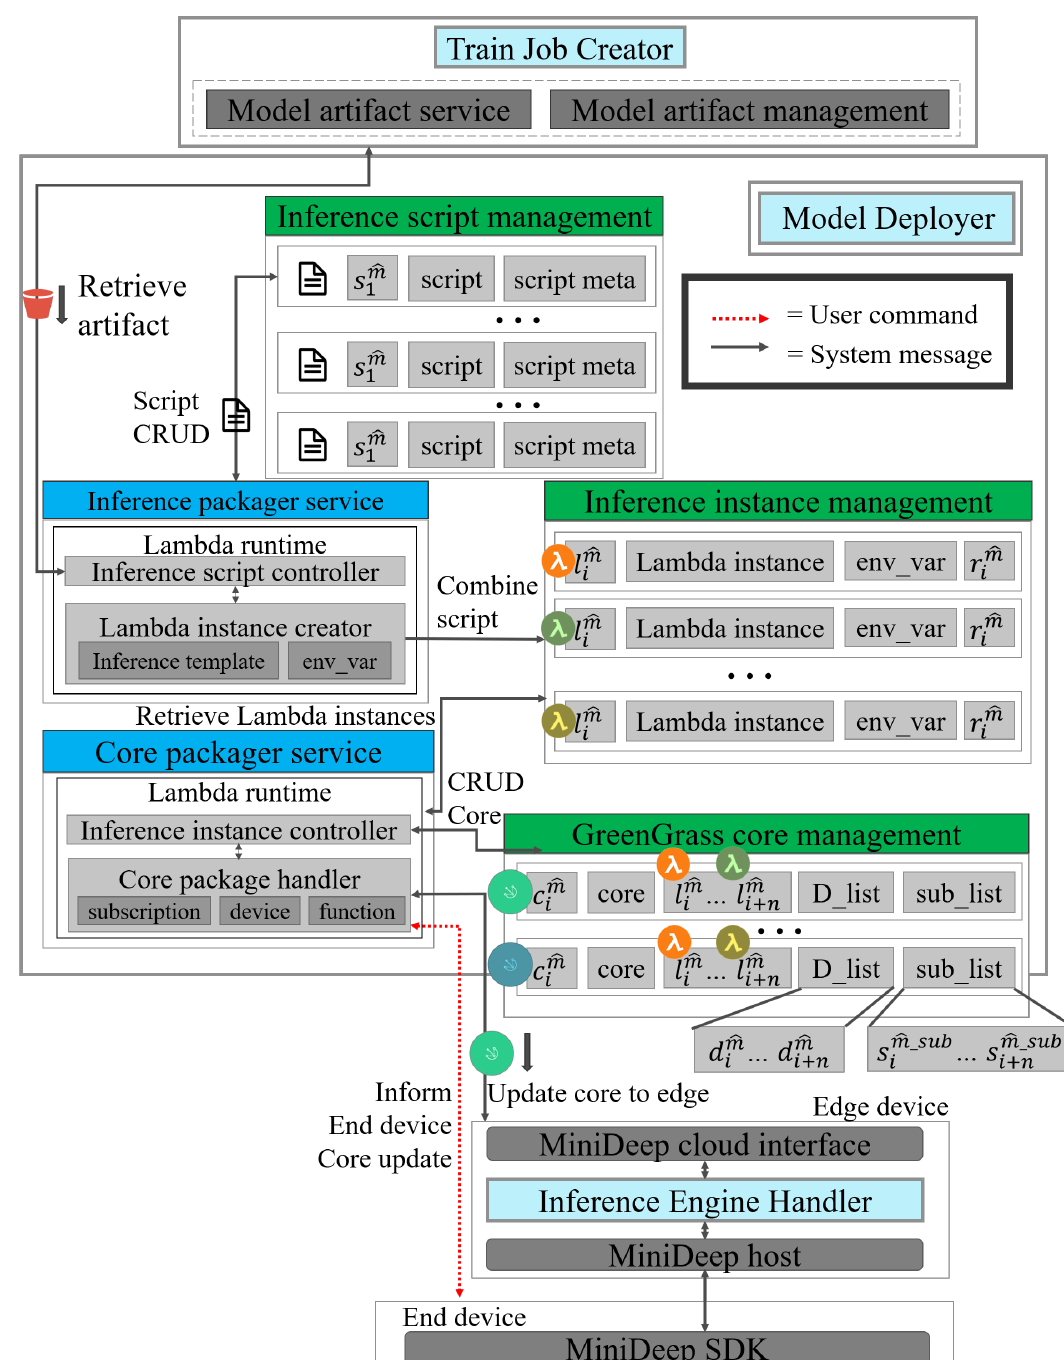
Figure 6. The detailed functions of Model